Question: What type of chart is this?
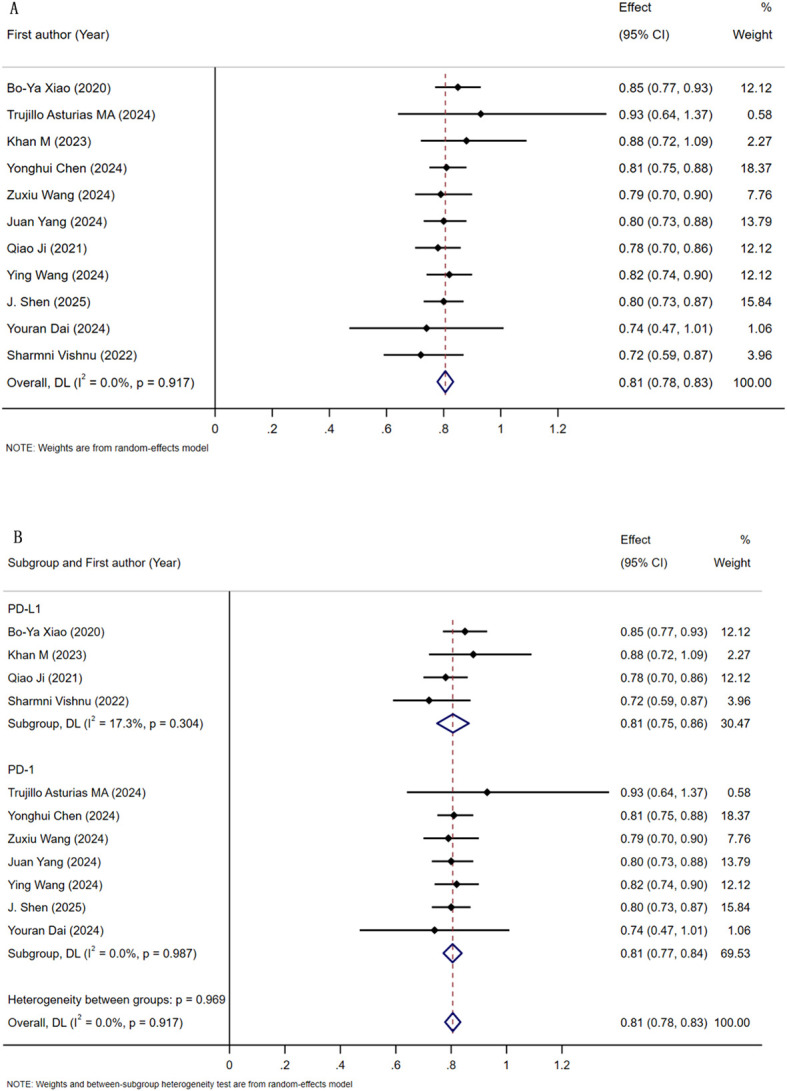
Answer: forest